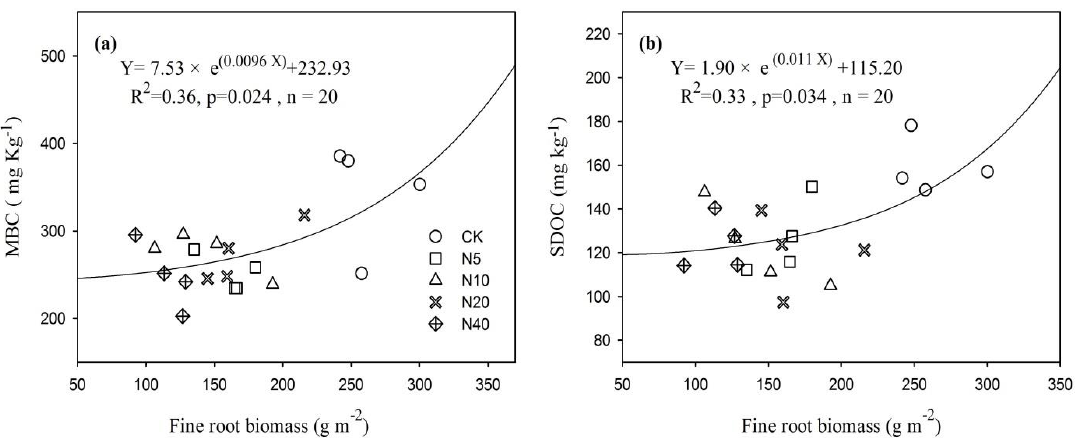
Figure 5. Relationship between fine root biomass and MBC ( a ) and SDOC ( b ) content.